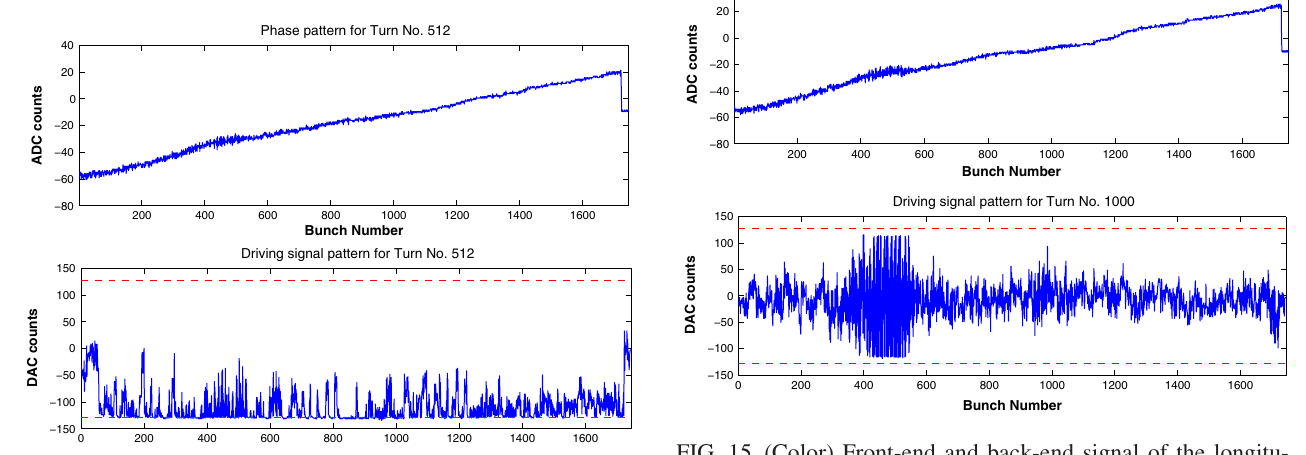
FIG. 15. (Color) Front-end and back-end signal of the longitu- dinal feedback system for turn 1000 of the time sequence shown in Figs. 8 and 9. The upper plot shows a set of unstable bunches around bunch 450. The lower plot depicts the response of the back-end signal to those unstable bunches. The large phase error drives the back-end signal to positive and negative saturation for the unstable